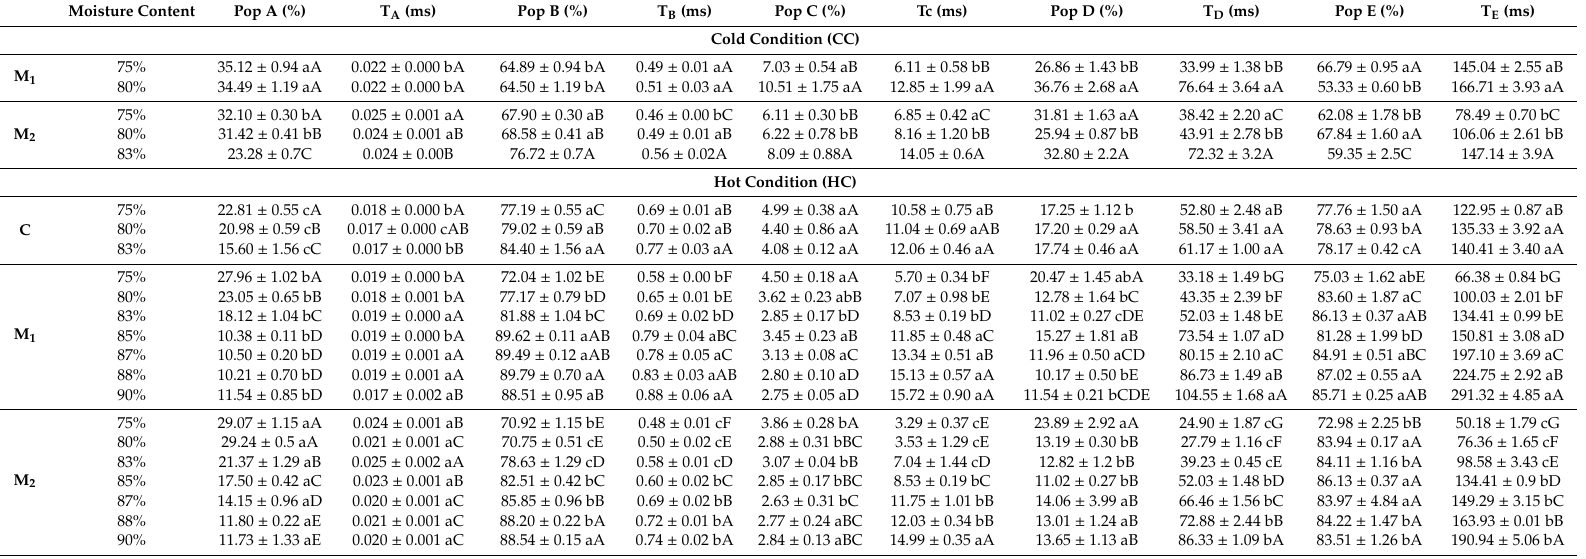
Table 4. Relaxation times (T A , T B, T C , T D and T E ) and relative abundances [pop A (%), pop B (%), pop C (%), pop D (%) and pop E (%)] of 1 H populations (A and B from 1 H FID, and C, D and E from 1 H T 2 experiment) of systems formed with three corn flours (C, M 1 and M 2 ) at di ff erent moisture contents (75%, 80%, 83%, 85%, 87%, 88% and 90%) and in the cold condition (CC) and hot condition